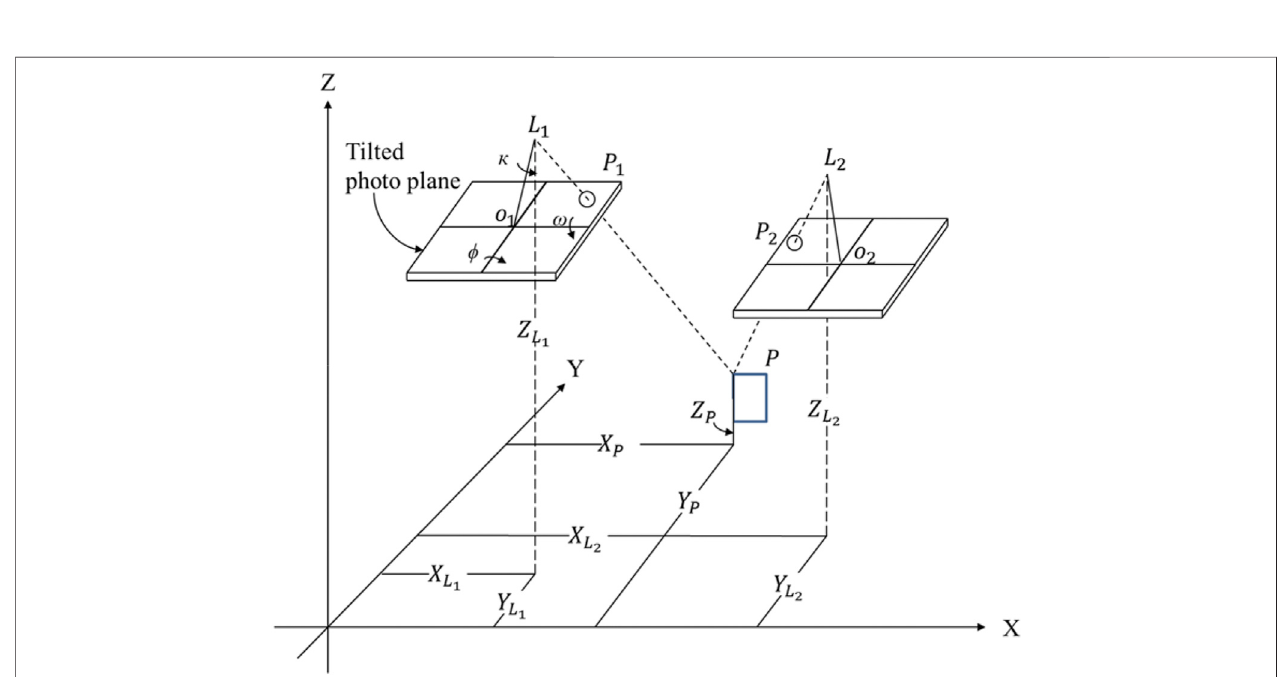
Frontiers in Earth Science |